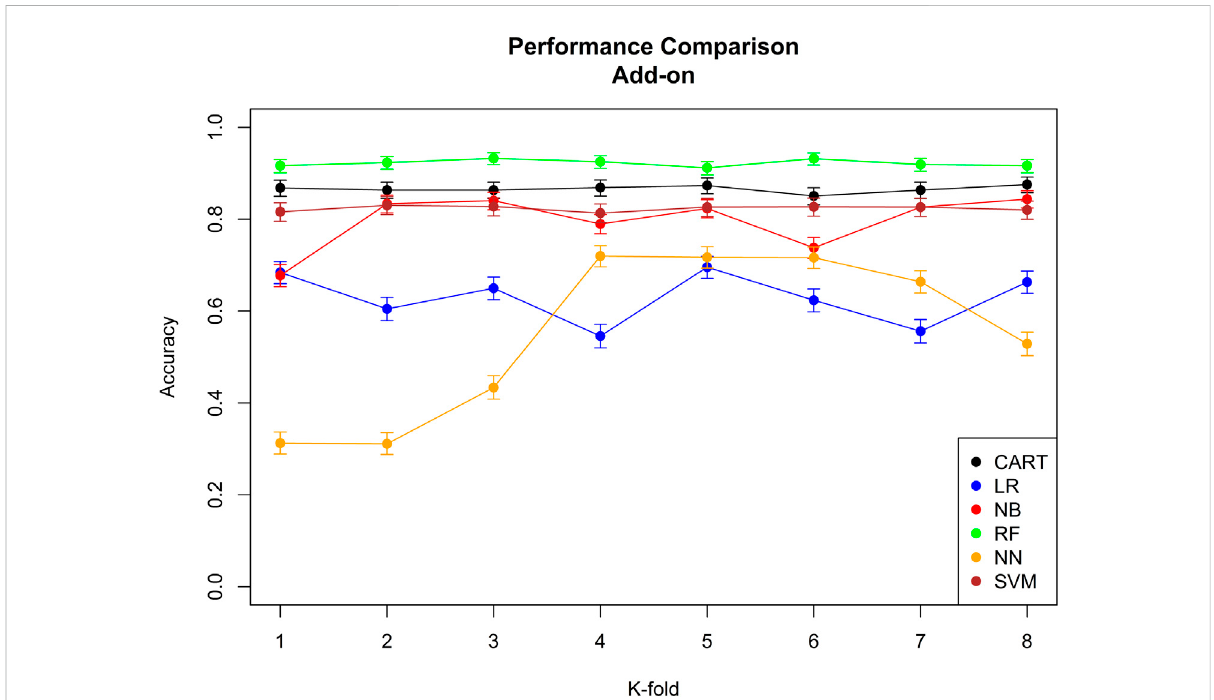
FIGURE 3 Performance comparison of all the six different machine learning/deep learning models used in approach 3 and the model ’ s accuracy of correctly classifying an add-on. CART = classi fi cation and regressiontree, LR = linear regression, NB = naïve Bayes, RF = random forest, NN = neural network, and SVM = support vector machine